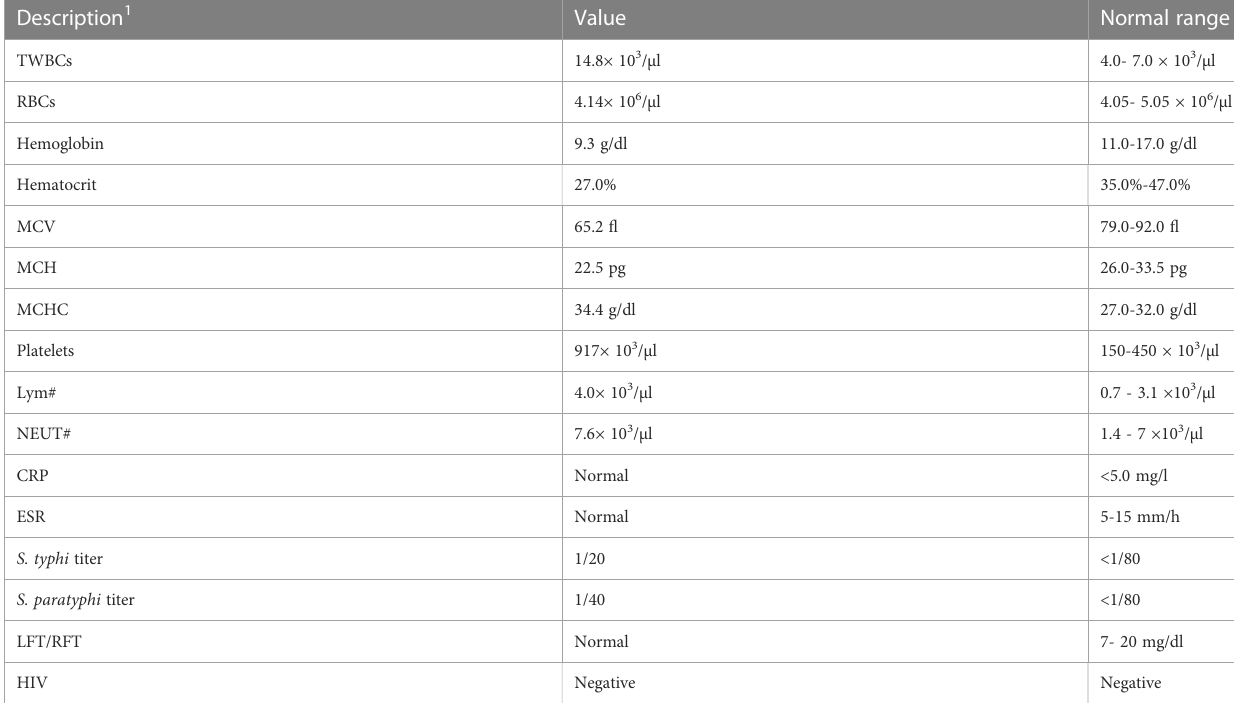
TABLE 1 Hematological, LFT, RFT, and HIV fi ndings in the patient ’ s blood sample. Description